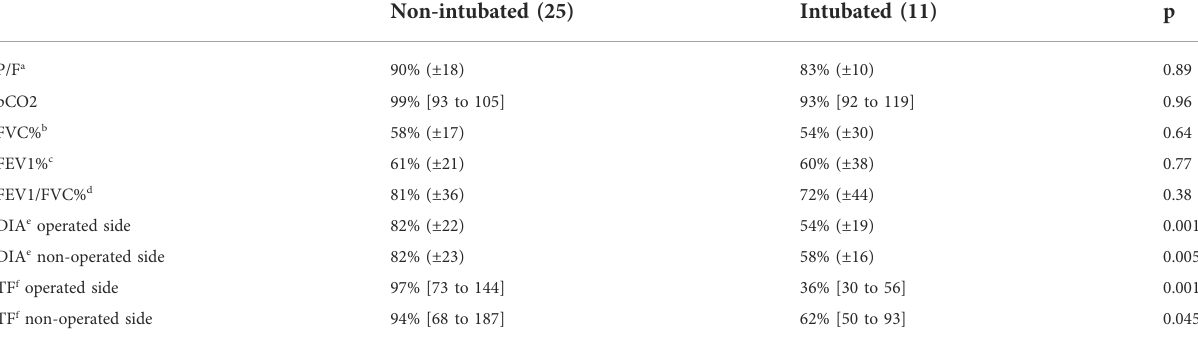
TABLE 2 Postoperative residual function of key